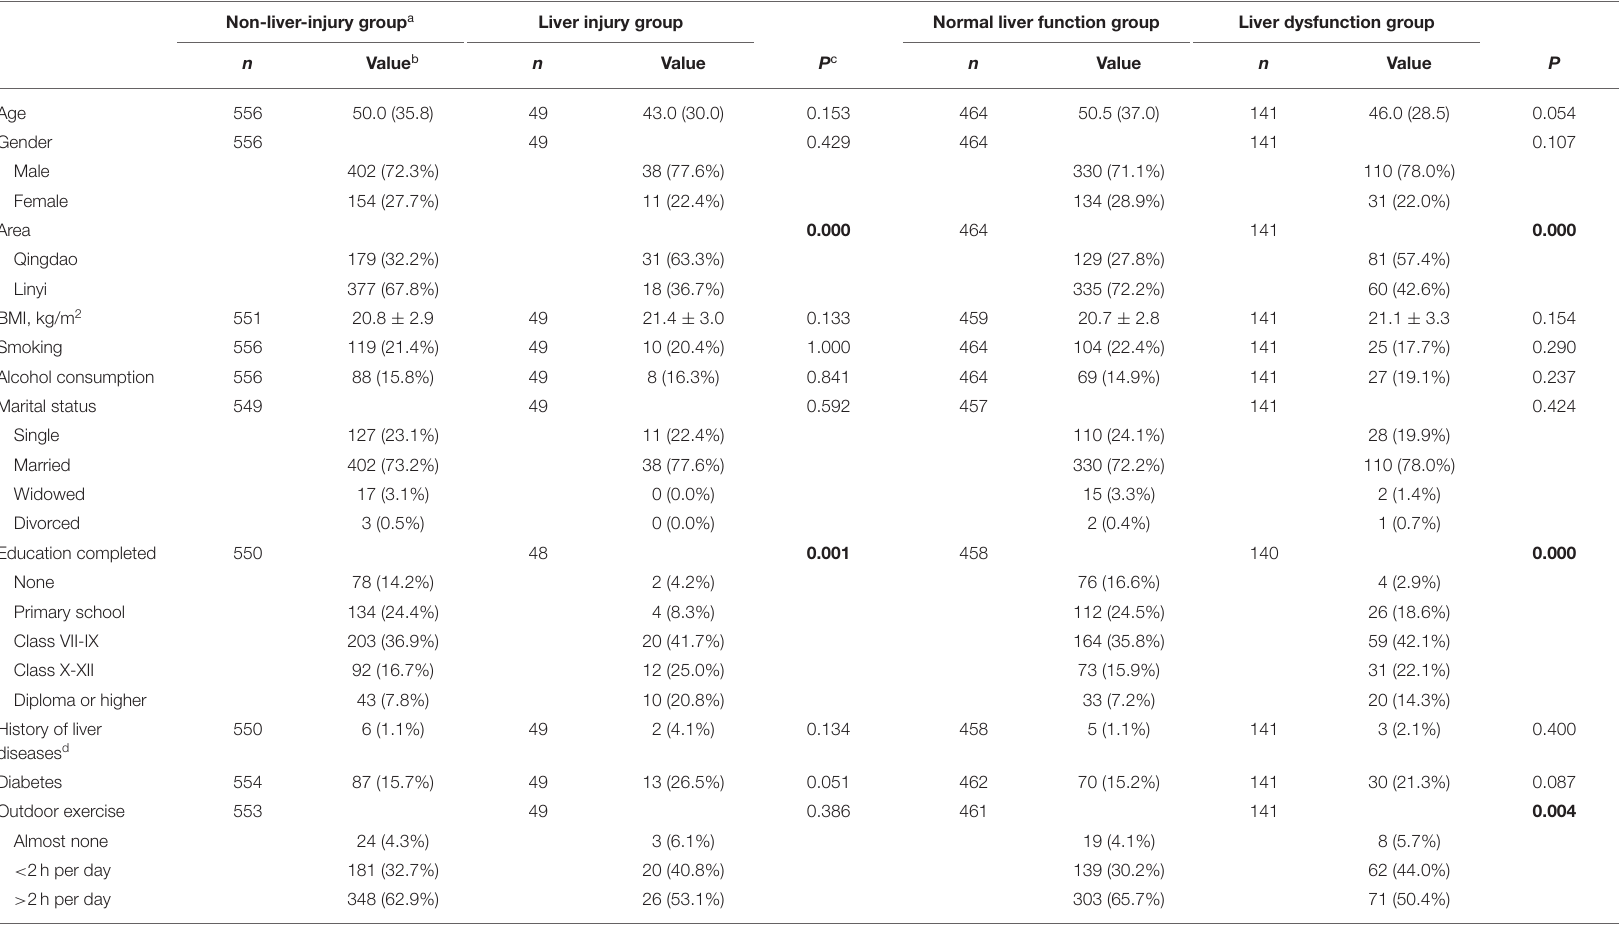
a Liver injury group had an alanine aminotransferase (ALT) or aspartate aminotransferase (AST) level of higher than two times of the upper limit of normal (ULN); Non-liver-injury group had an ALT and AST level of equal or lower than two times of the ULN. Liver dysfunction had an ALT or AST level of higher than the ULN; Normal liver function group had an ALT and AST level of equal or lower than the ULN. The ULN for ALT and AST is 40 U/L. b Non-normal variables were presented as median (IQR); normal variables were presented as mean ± SD; categorical variables were presented as number of patients in a specific category (percentage). c P was calculated between the non-liver-injury group and liver injury group, and between the normal liver function group and liver dysfunction group. The statistical difference for the non-normal data was tested by a Mann-Whitney U-test; the difference for the normal data was tested by a t-test; the difference for the categorical data was tested by a χ 2 -test. d The intergroup difference for the history of liver diseases was tested by a Fisher’s exact-test. P values were labeled in bold if they were less than